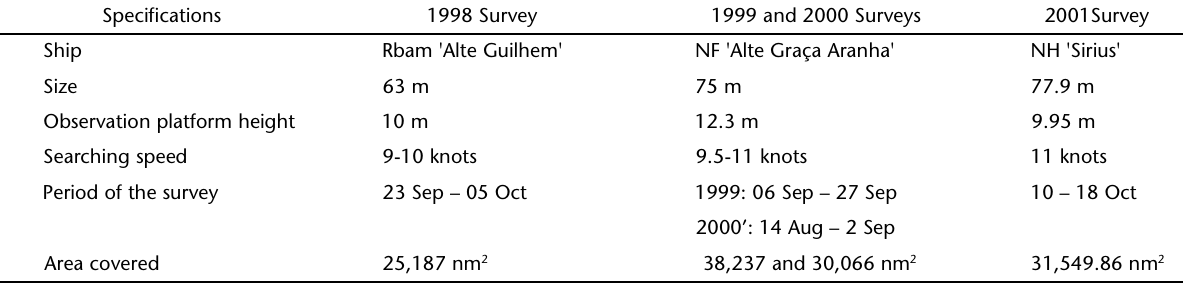
Table II. Specifications of the ships and the period of the surveys for large whales off Northeastern Brazil.